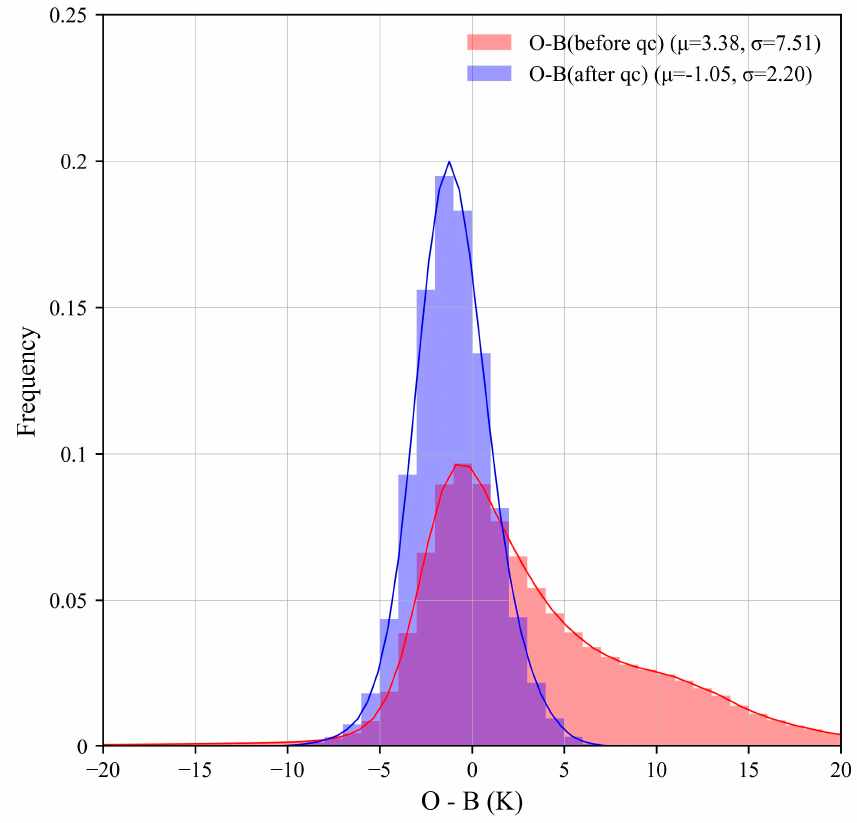
Figure 5. O-B probability density function (PDF) profiles of the 37 V SMR channel. The O-B statistics are based on GRAPES-GFS from 10 to 24 July 2021. The red/blue bars correspond to the PDF of the O-B before/after the QC procedures, respectively.